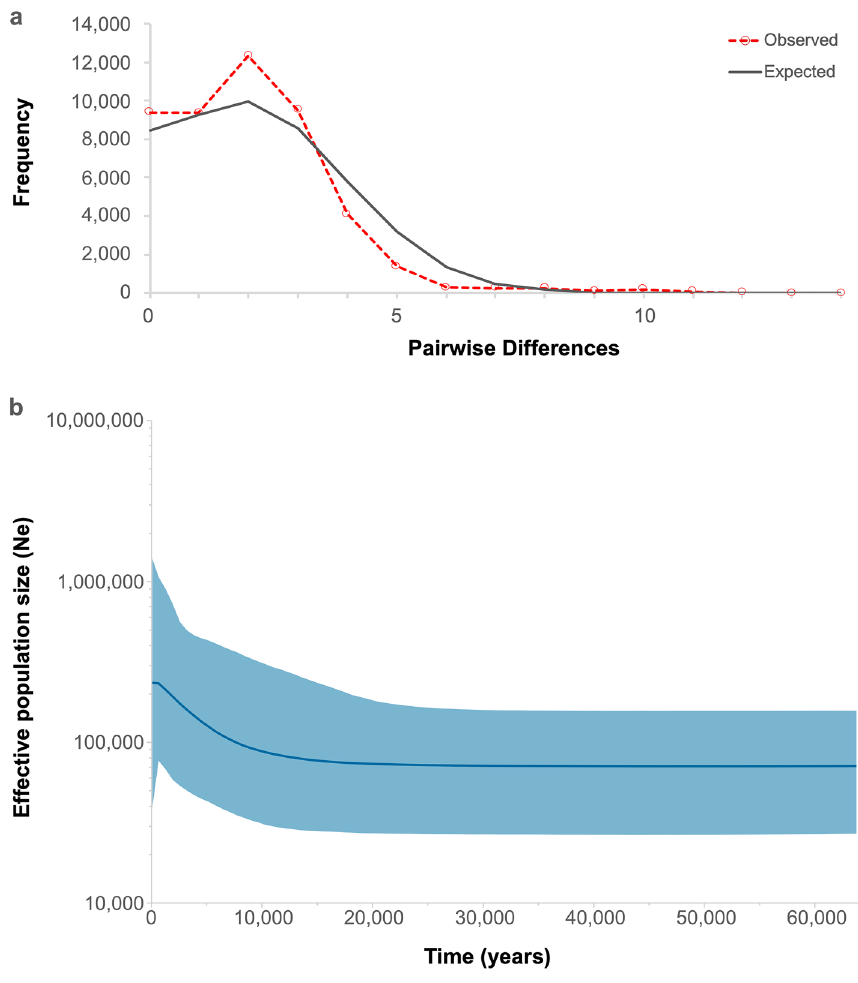
Figure 3. ( a )—Mismatch distribution analysis according to a population expansion scenario of Commerson’s dolphin ( Cephalorhynchus commersonii ). The observed number of differences are given as a red dashed line, and those expected under a population expansion model are given as a black solid line. ( b )—Bayesian Skyline plot representing historical demographic trends of Commerson’s dolphin population. Estimates of effective population size (Ne) means are joined by a solid line; whereas the colored area corresponds to the credibility interval based on 95% highest posterior density